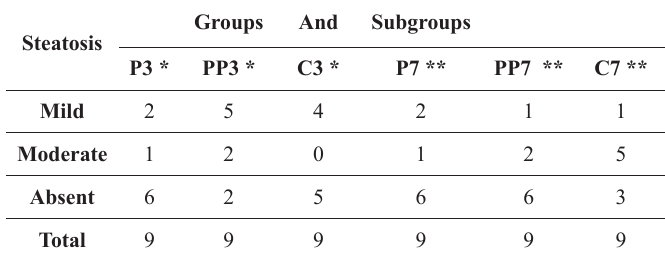
TABLE 2 - Frequency of hepatic steatosis in animals of the 3 groups at both time points (3 and 7 days) - subgroups P3, P7, PP3, PP7, C3, C7): P Group - pneumoperitoneum for 30 minutes